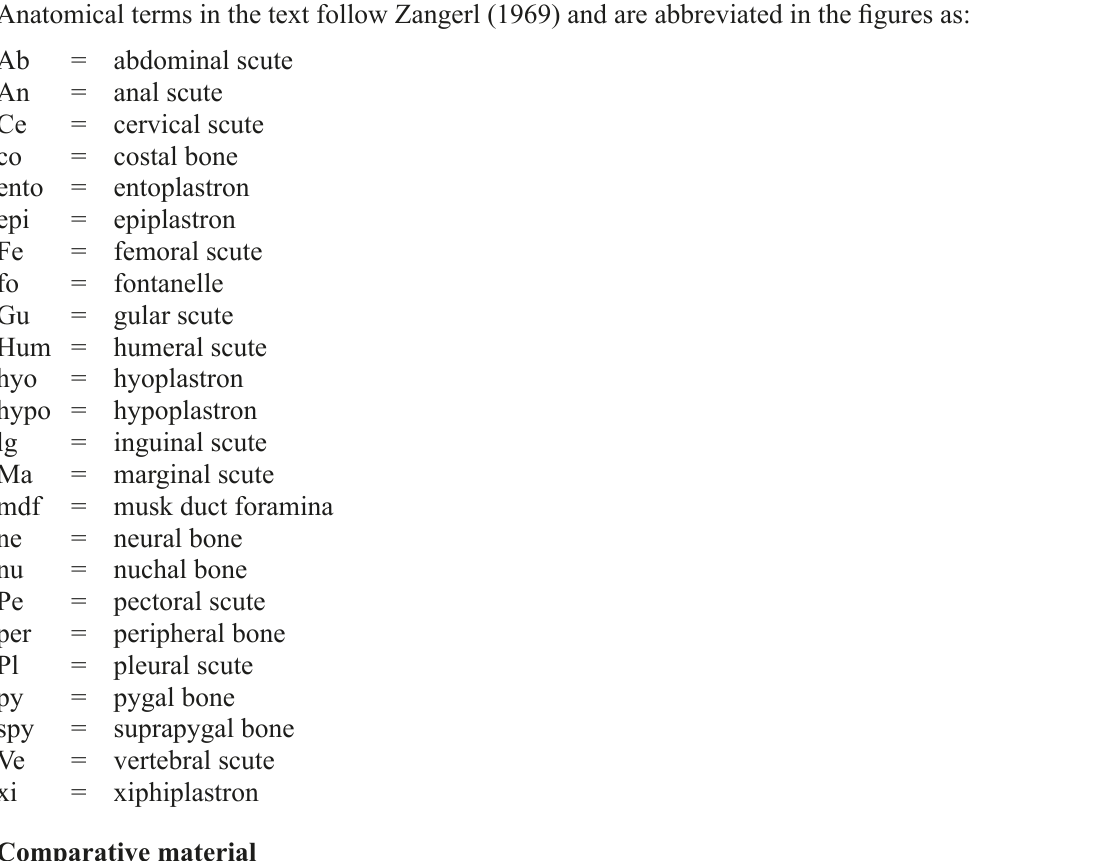
Anatomical terms in the text follow Zangerl (1969) and are abbreviated in the figures